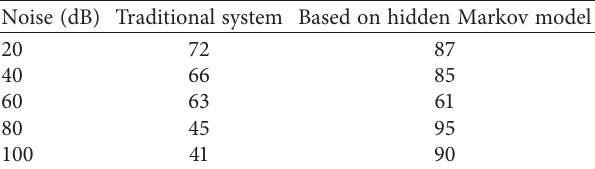
Table 2: Comparison of the recognition effect of the two systems (%). Noise (dB) Traditional system Based on hidden Markov